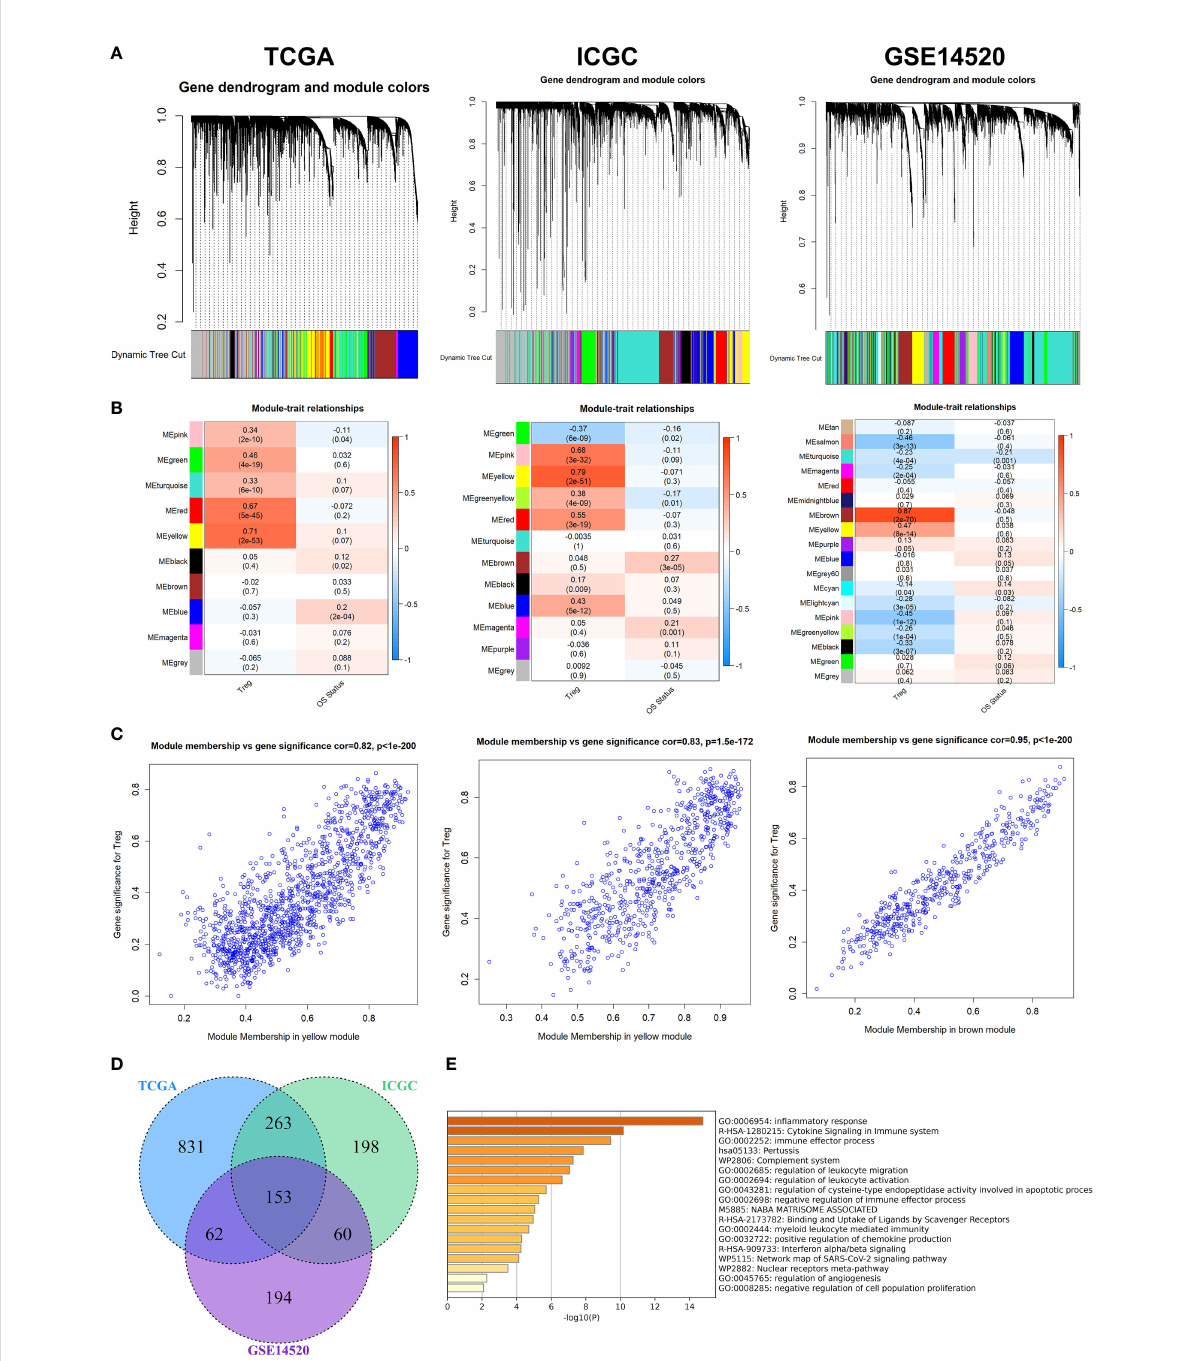
FIGURE 1 WGCNA for Tregs-related genes. (A) The coexpression network was established in the TCGA, the GSE14520, and the ICGC cohorts. (B) Heatmap demonstrating the correlation between module eigengenes and Tregs. (C) Determination of modules most signi fi cantly associated with Tregs in fi ltration. (D) 153 overlapping genes among the three cohorts were identi fi ed as Tregs-related genes. (E) The biological importance of these Tregs-related genes was mainly enriched in the immune-in fl ammatory response and regulation of